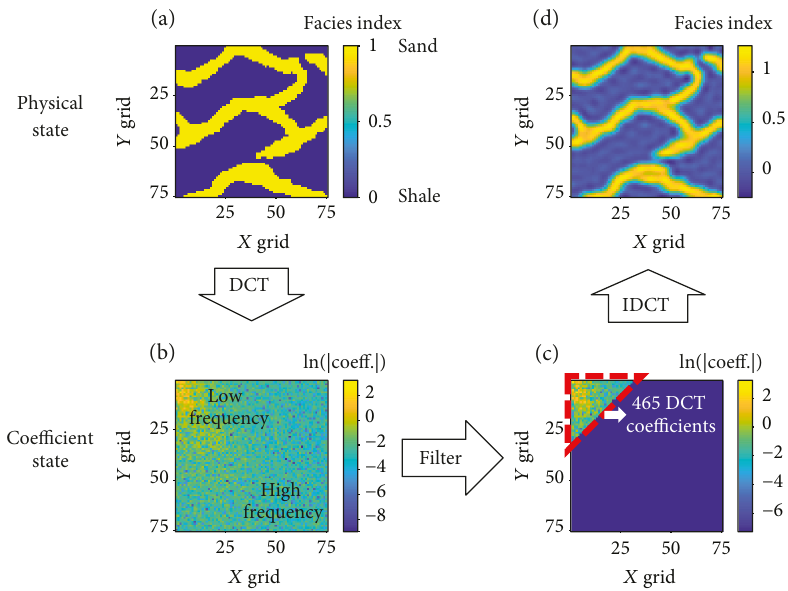
Figure 6: Example of discrete cosine transform (DCT) and inverse DCT (IDCT) applied to the reproduction of shale and sand facies of a channelized